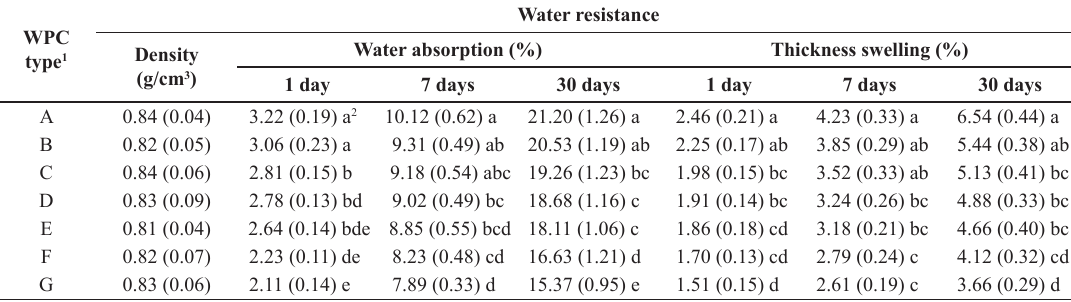
Table 2. Density and water resistance of WPC panels with and without charcoal flour. WPC type 1